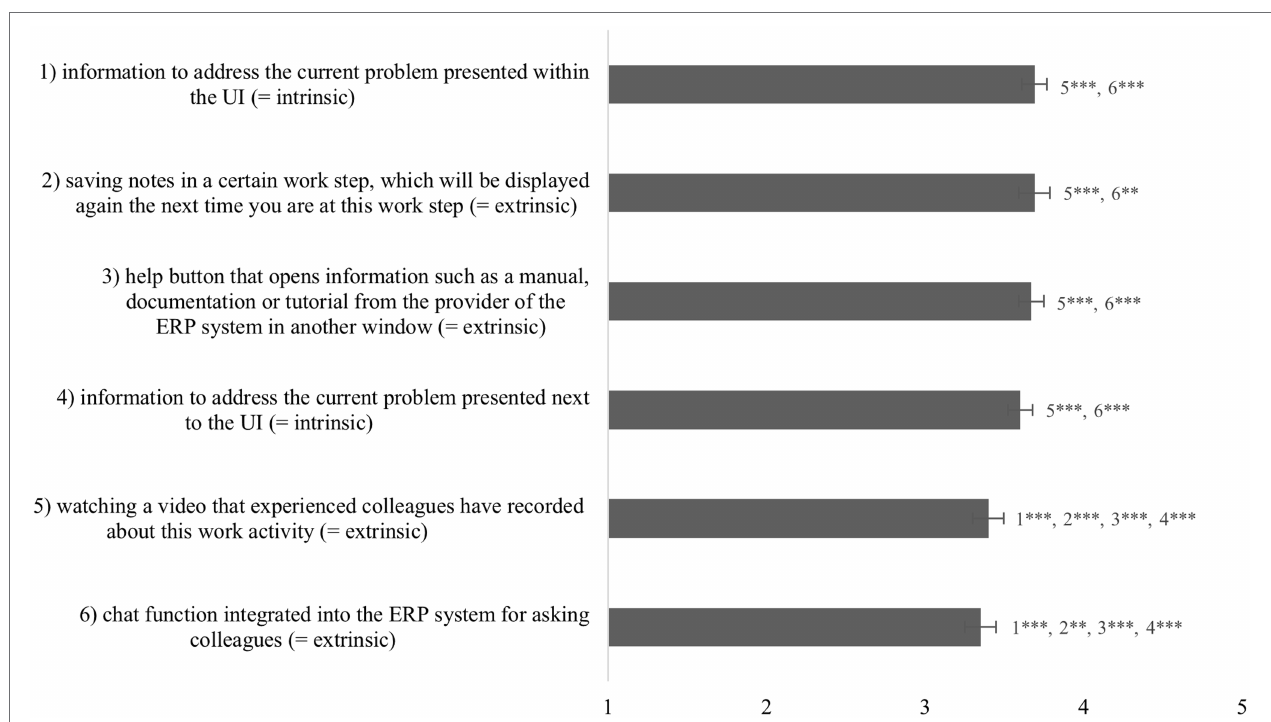
FIGURE 5 | Significant differences, means and confidence intervals of the perceived usefulness of EPSS characteristics. Scale: 1 = not helpful at all, 3 = partly helpful, 5 = very helpful. * p < 0.05; ** p < 0.01; and *** p <